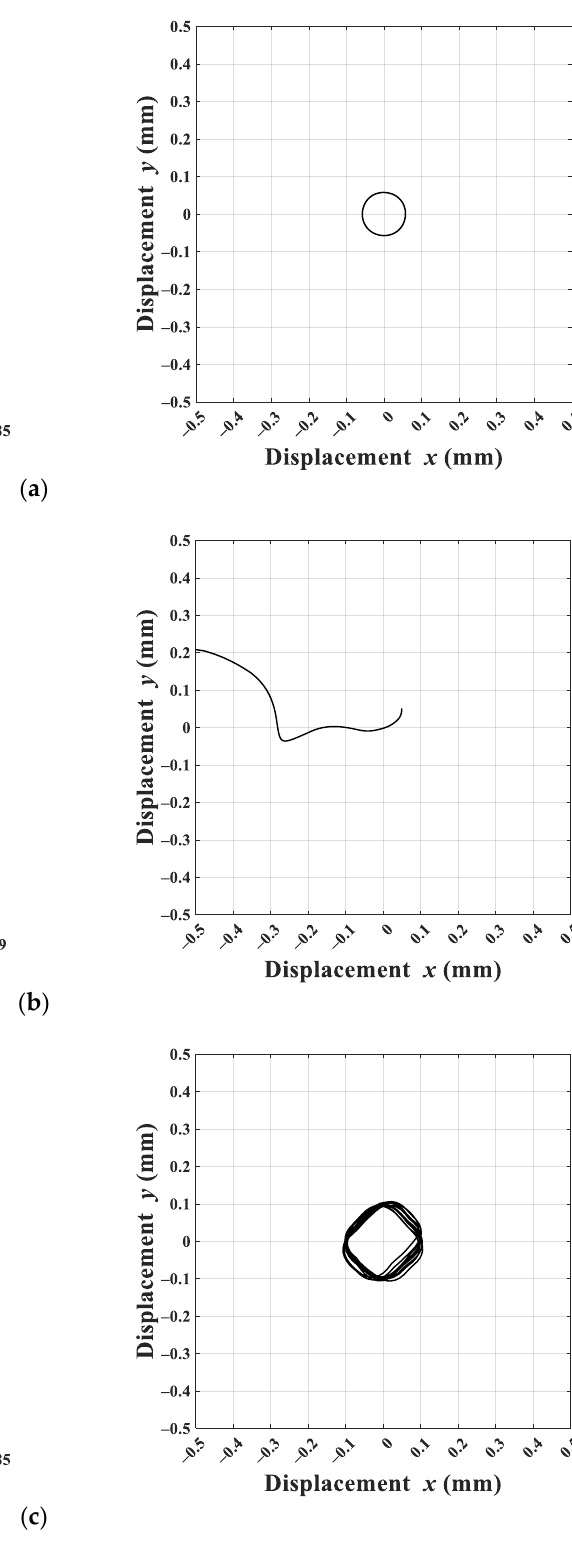
= 150 rad/s, 05.0 00 == yx